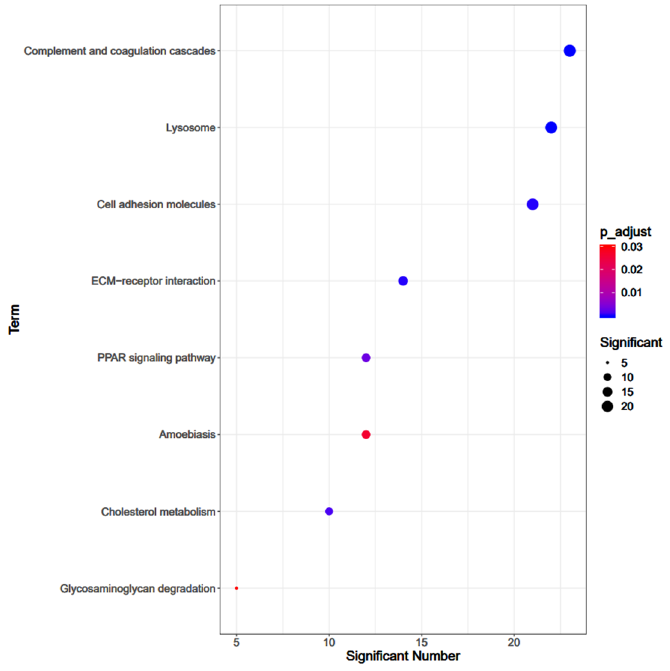
Figure 6. The KEGG pathway analysis of the differentially expressed proteins. Int. J. Environ. Res. Public Health 2021 , 18 , x FOR PEER REVIEW